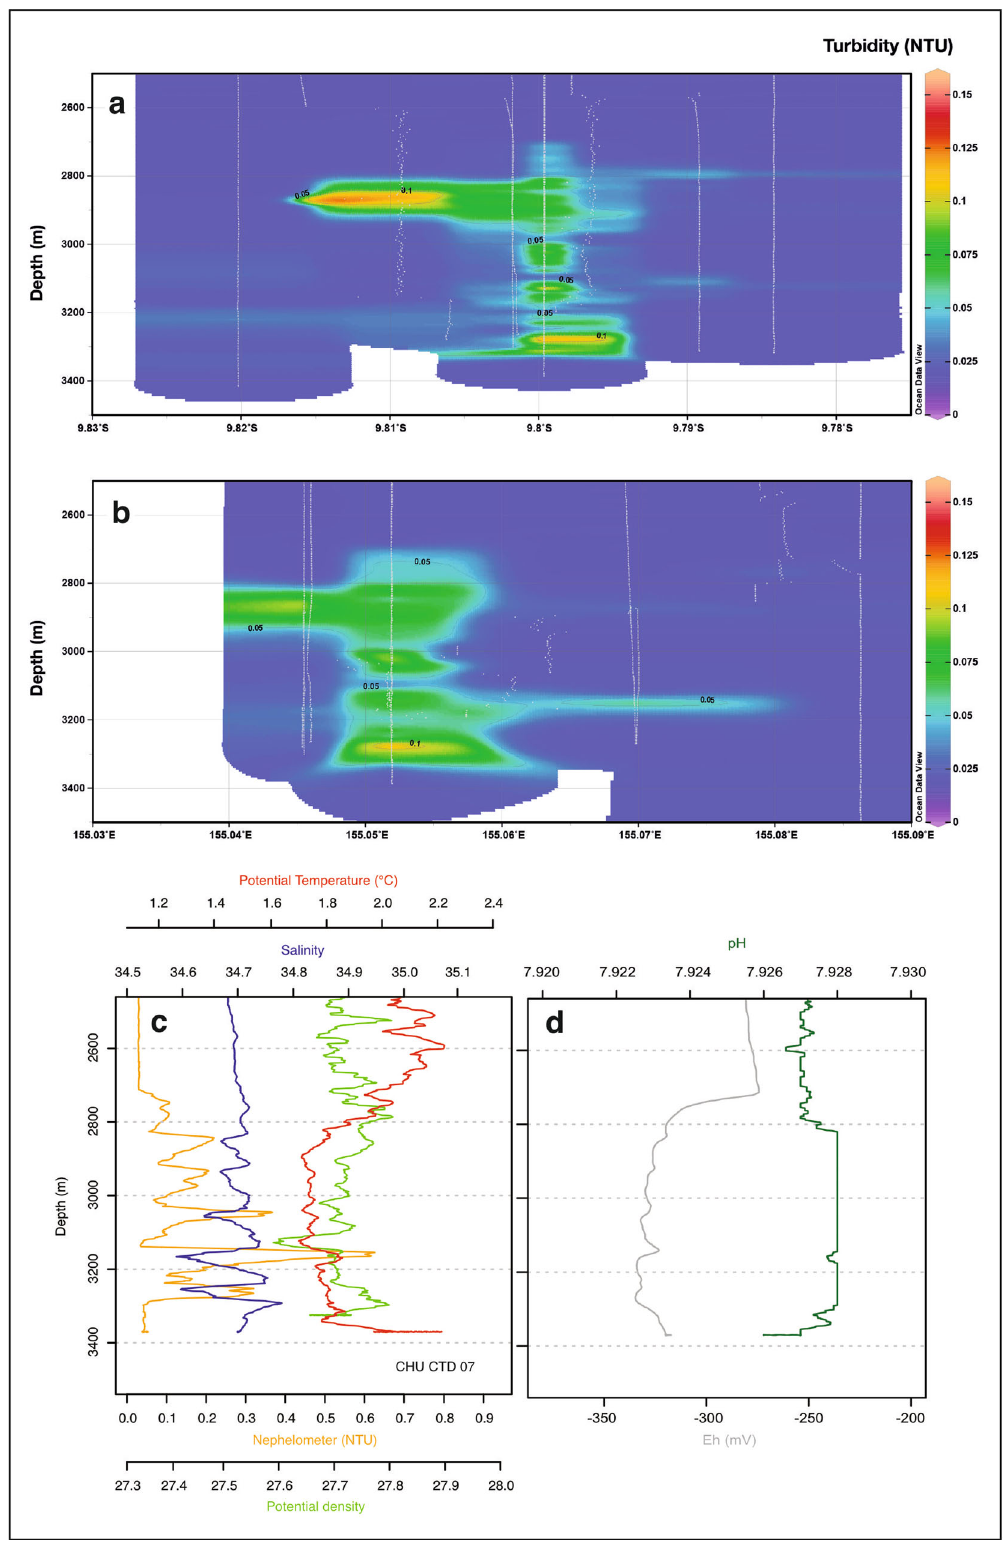
Fig. 3 Physico-chemical characteristics of hydrothermal plumes above La Scala Vent Field. N-S ( a ) and NE-SW ( b ) sections of turbidity anomalies above Segment 3. The section compiles data from tow-yo surveys (CTD-01 to CTD-03) and vertical casts (CTD-06 and CTD-07) (grey lines). c , d Nephelometry (yellow), density (light green), salinity (blue), temperature (red), Eh (grey), and pH (dark green) vertical pro fi les in the non-buoyant plume of ‘ La Scala ’ vent site